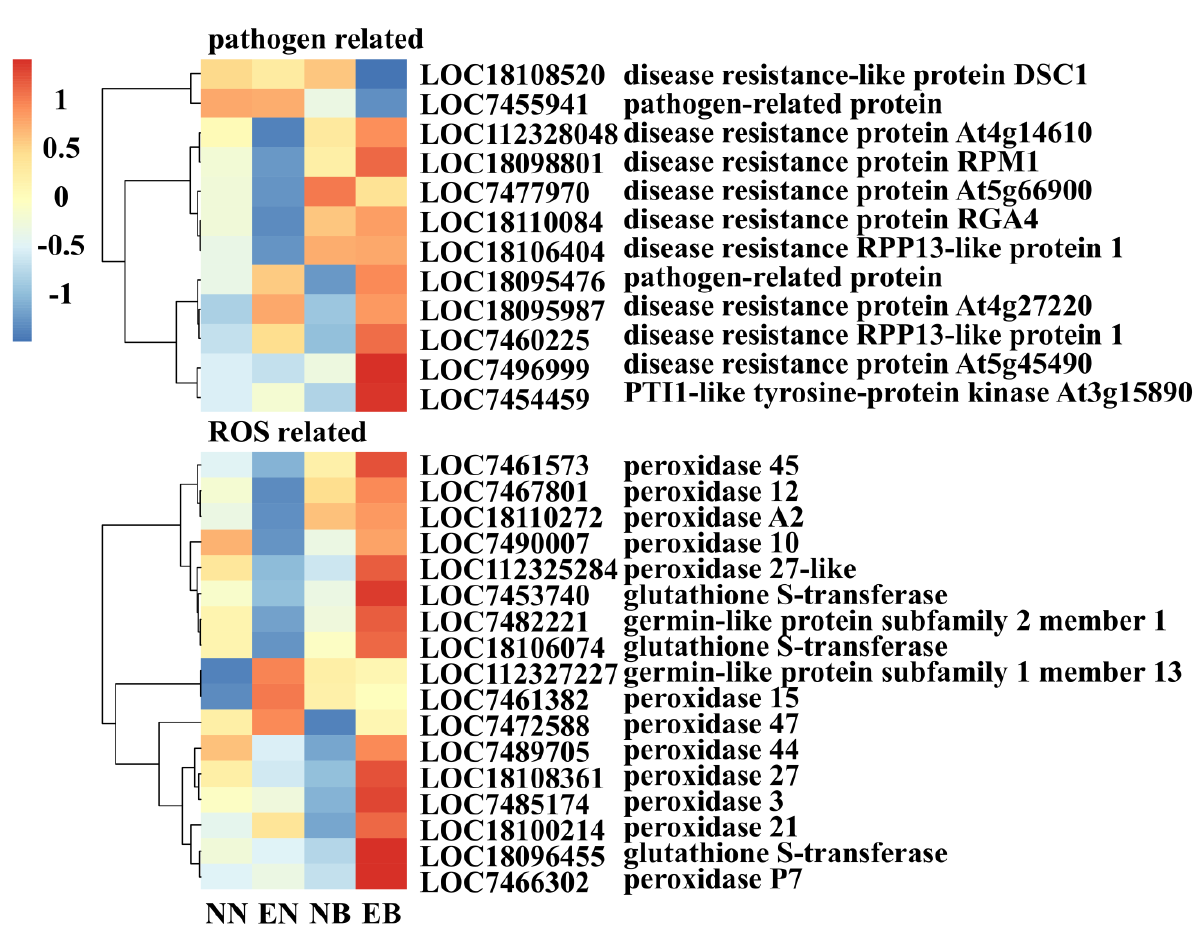
Figure 5. Heat map of DEGs related to disease resistance and antioxidant.